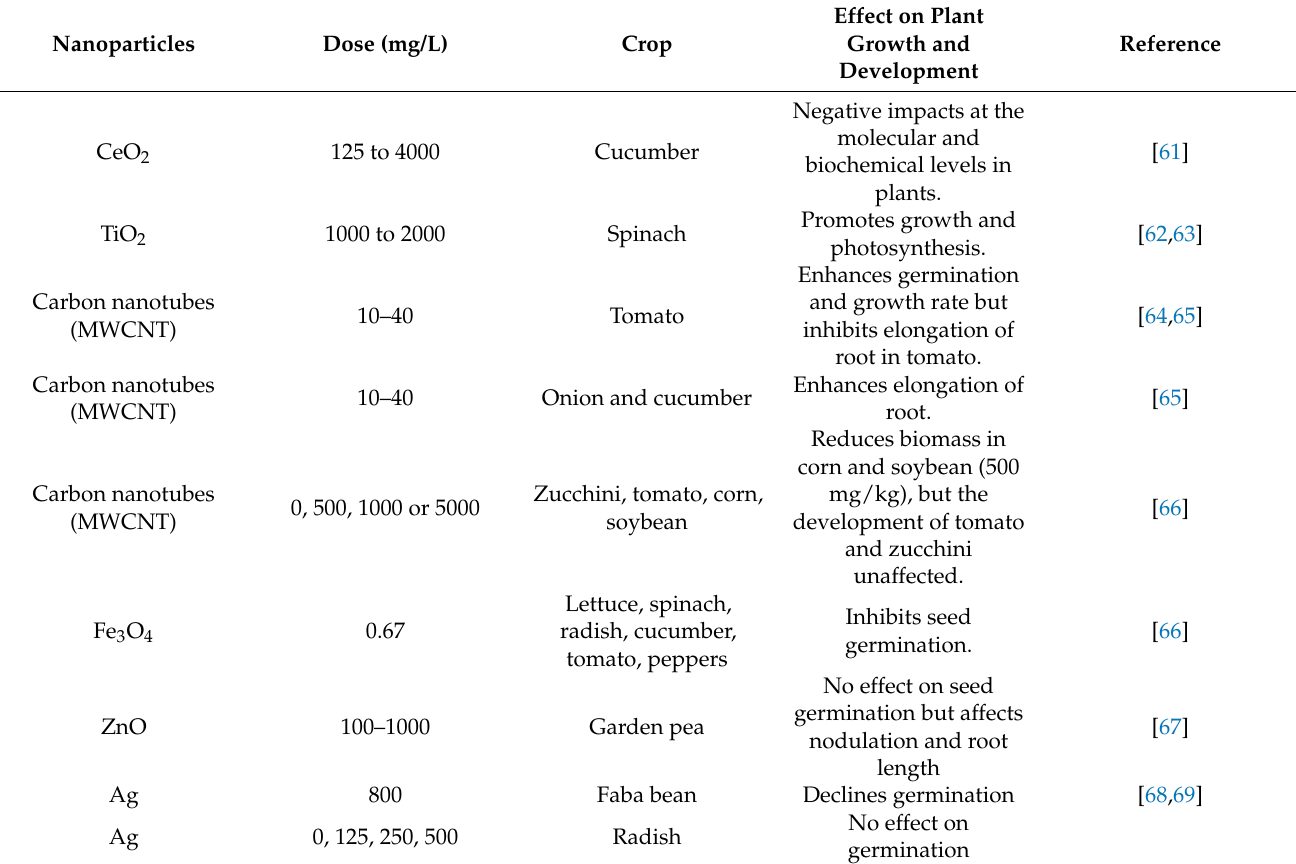
Table 2. Influence of nanoparticles (NPs) on germination, growth, development and yield of horticultural crops.